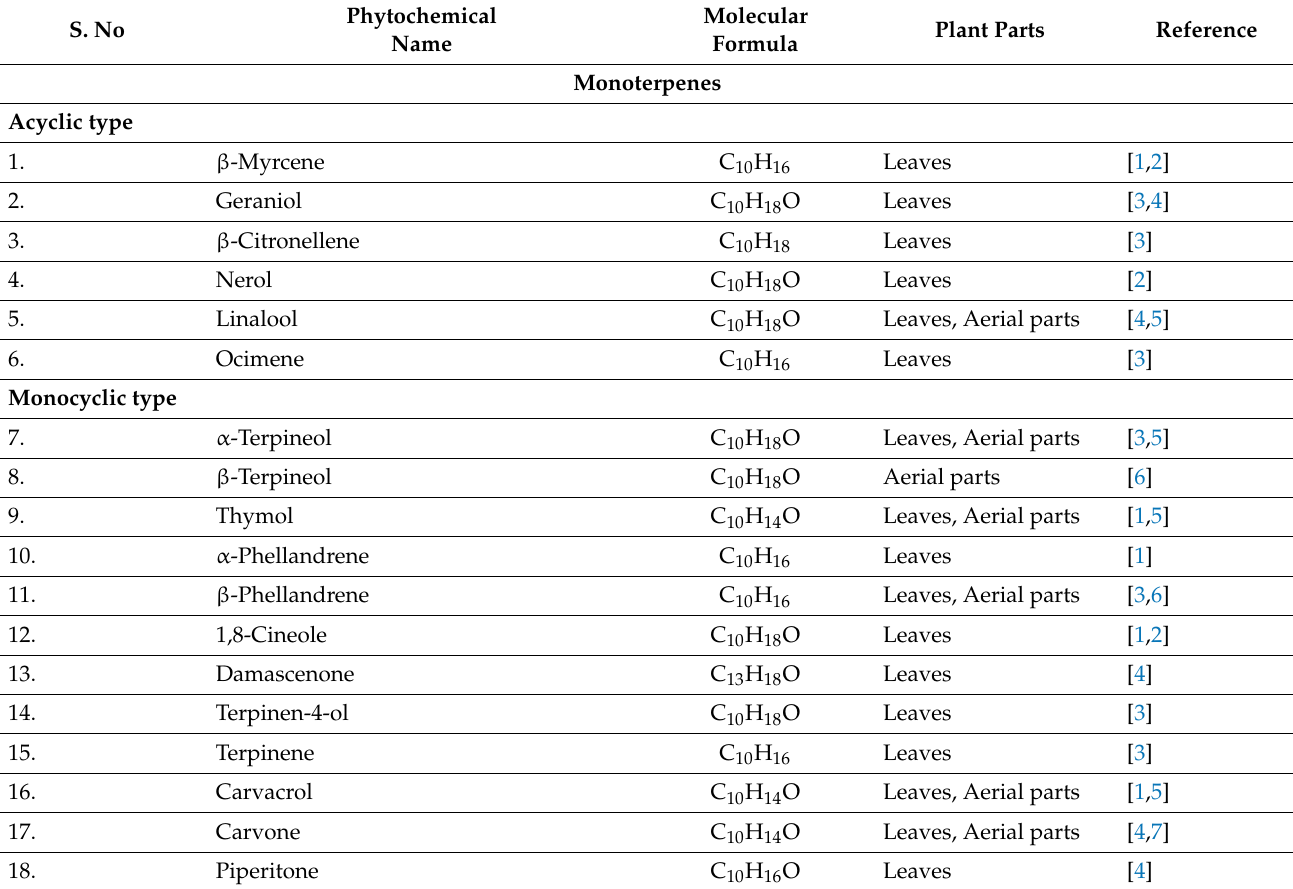
Table 1. Different types of phytoconstituens reported from P. frutescens